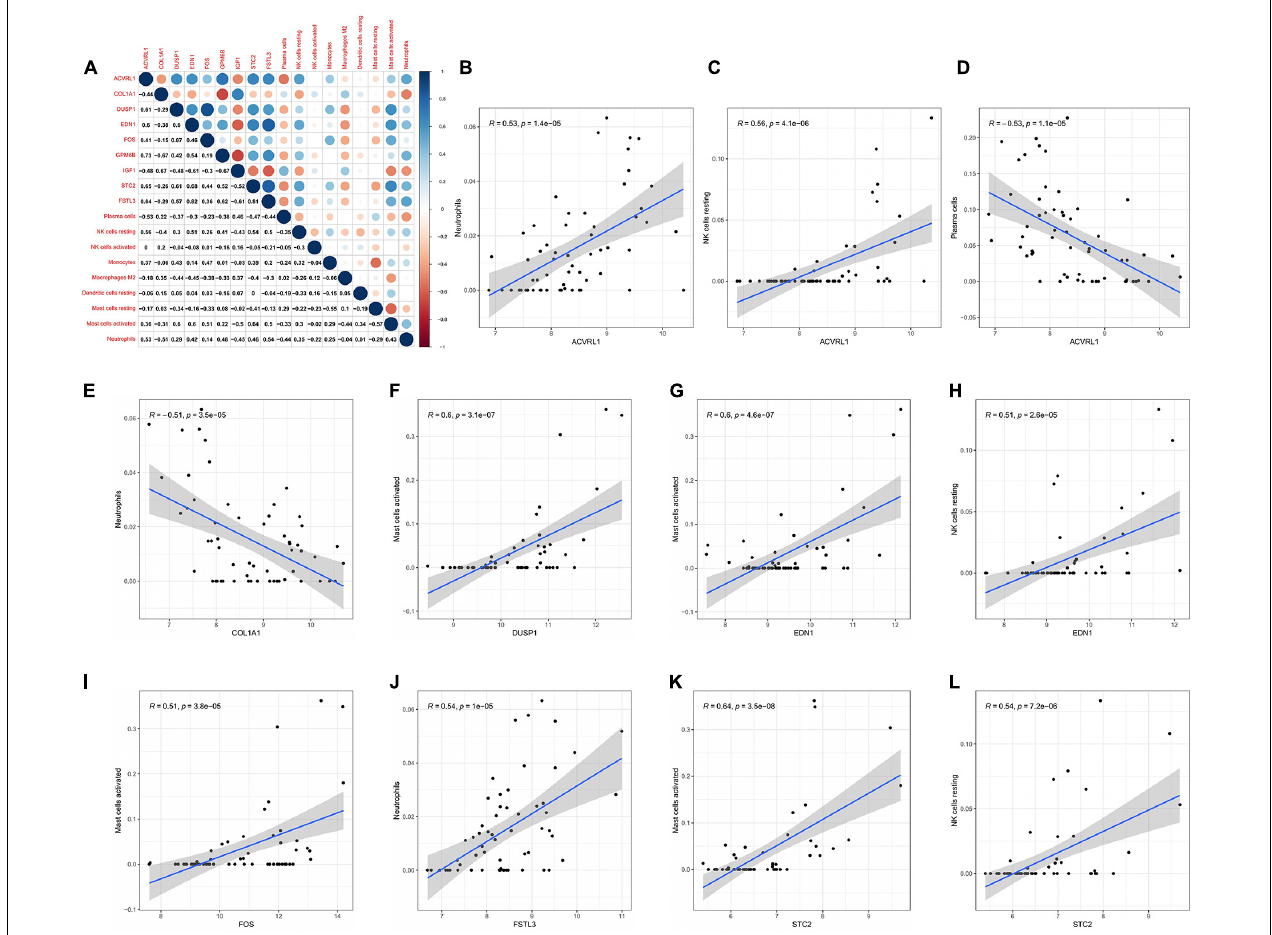
FIGURE 7 | Co-expression patterns of differential immune cells and core mRNAs. (A) The correlation between core mRNAs and differential immune cells. (B–L) The significantly correlated pairs with correlation coefficient > 0.5 and P < 0.001. mRNAs, messenger